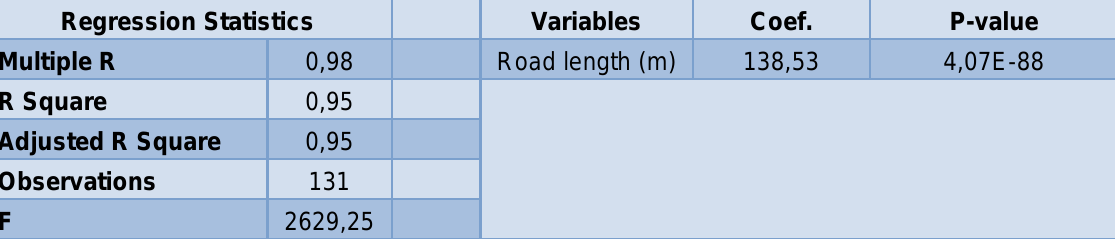
Table 16 Multiple regression results among total project cost and road length when intercept =